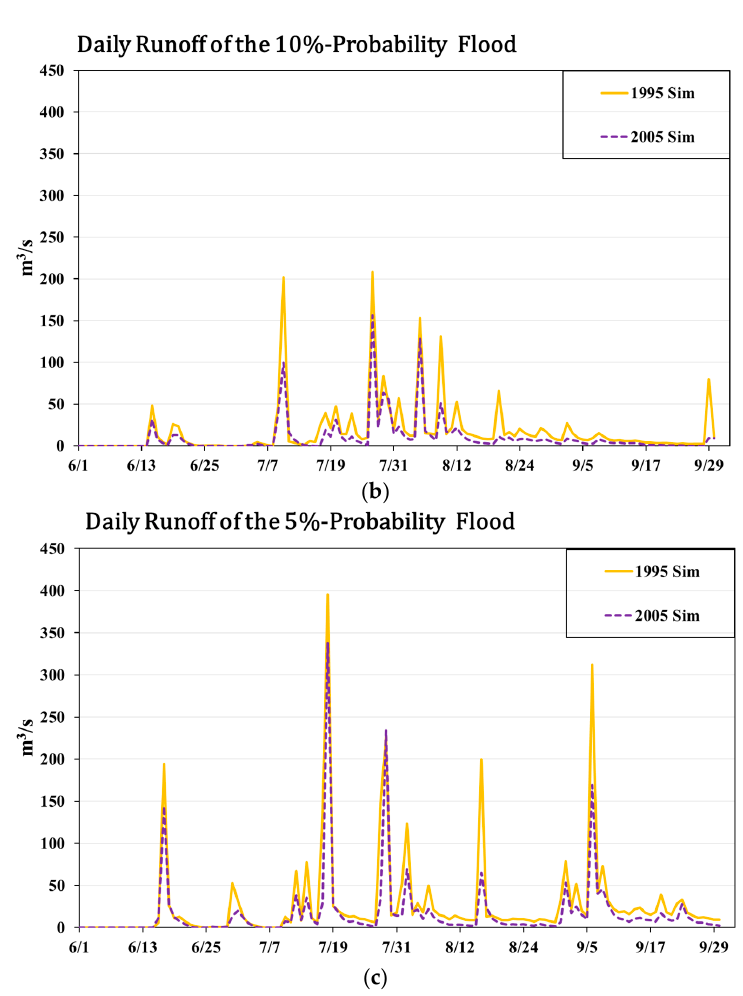
Figure 4. ( a ) The daily runoffs of the20% ‐ probability flood under 1995 land use and 2005 land use; ( b ) The daily runoffs of the 10% ‐ probability flood under 1995 land use and 2005 land use; ( c ) The daily runoffs of the 5% ‐ probability flood under 1995 land use and 2005 land use.